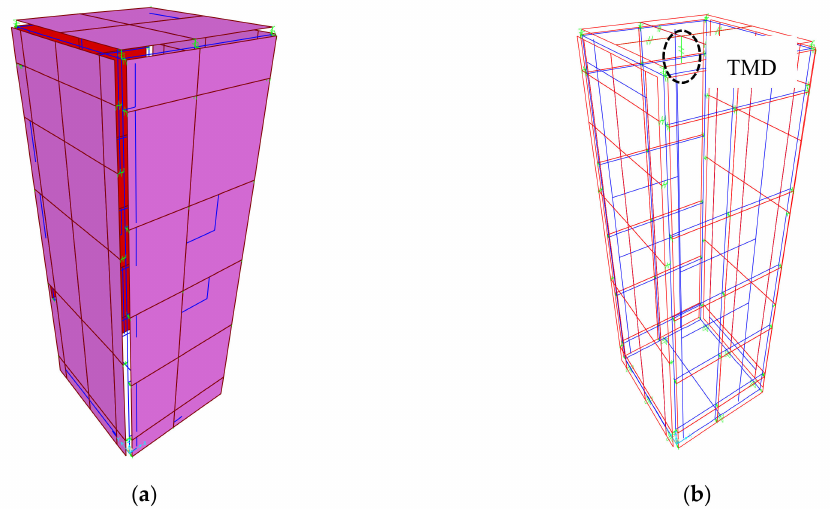
Figure 10. Numerical models of electrical cabinet: ( a ) Without a TMD; and, ( b ) With a